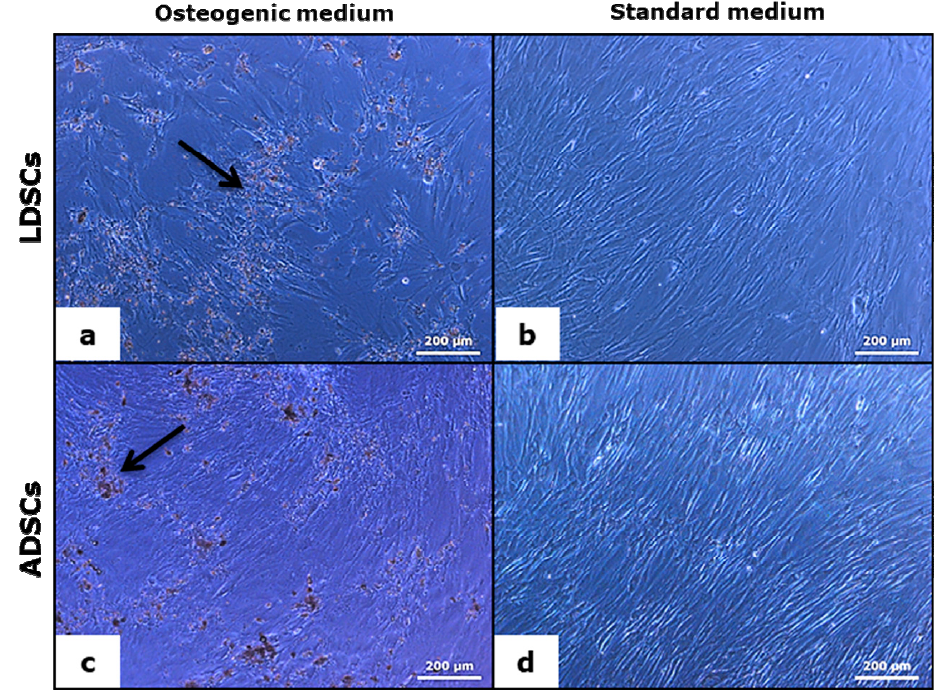
Figure 9. Light microscopic analysis of osteoblasts’ formation after 16 days of osteogenic differentiation; LDSCs in osteogenic medium (OS) ( a ) LDSCs in standard medium (DM) ( b ) ADSCs in OS medium ( c ) and ADSCs in DM medium ( d ); phase contrast with objective magnification 10 × ; arrows indicate inorganic material deposition.